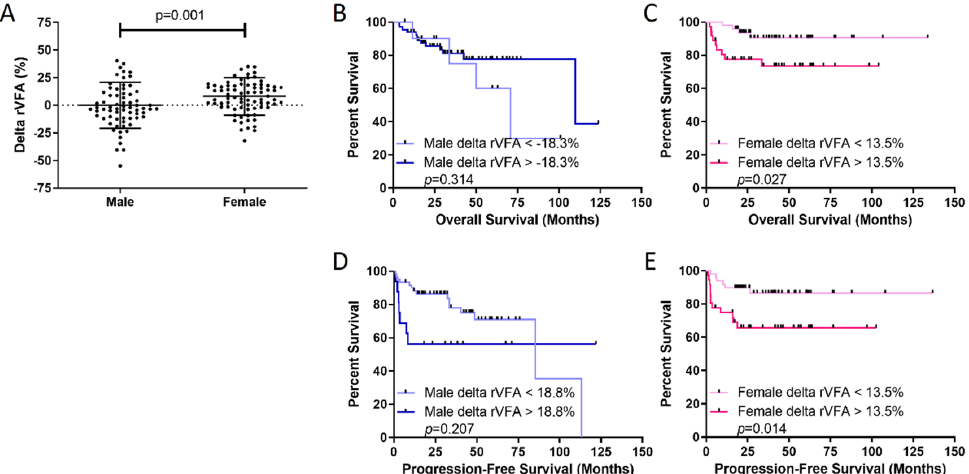
Figure 3. Visceral fat is gained in females during chemotherapy and predicts poor outcomes in females. ( A ) Females gain more visceral fat than males over the course of therapy, measured by the delta rVFA (final rVFA- initial rVFA/initial rVFA). Overall survival (OS) in ( B ) males and ( C ) females and progression-free survival in ( D ) males and ( E ) females demonstrate that higher delta rVFA predicts poor outcomes for females. Delta rVFA thresholds identified with optimized biomarker threshold algorithm. p -value was calculated with the log-rank test.